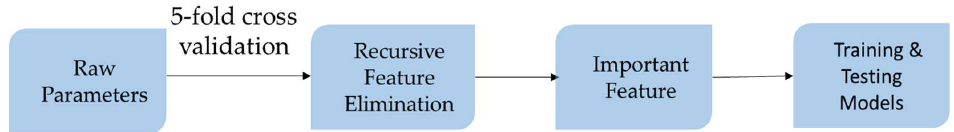
Table 2. The landmarks of seven muscles.